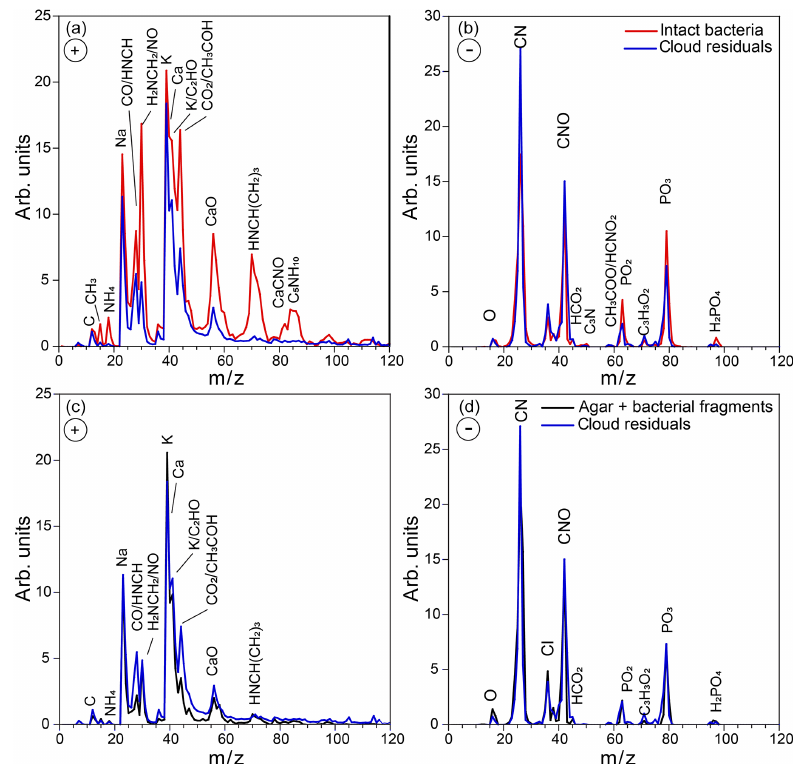
Figure 6. Positive (a) and negative (b) ion average mass spectra of cloud residuals sampled during Expansion 1 (blue) superimposed on the average MS of intact bacteria (red). Panels (c) and (d) show the same cloud residuals average MS superimposed on the reference average MS of the small particle mode, composed of Pseudomonas syringae bacterial fragments mixed with agar (black).